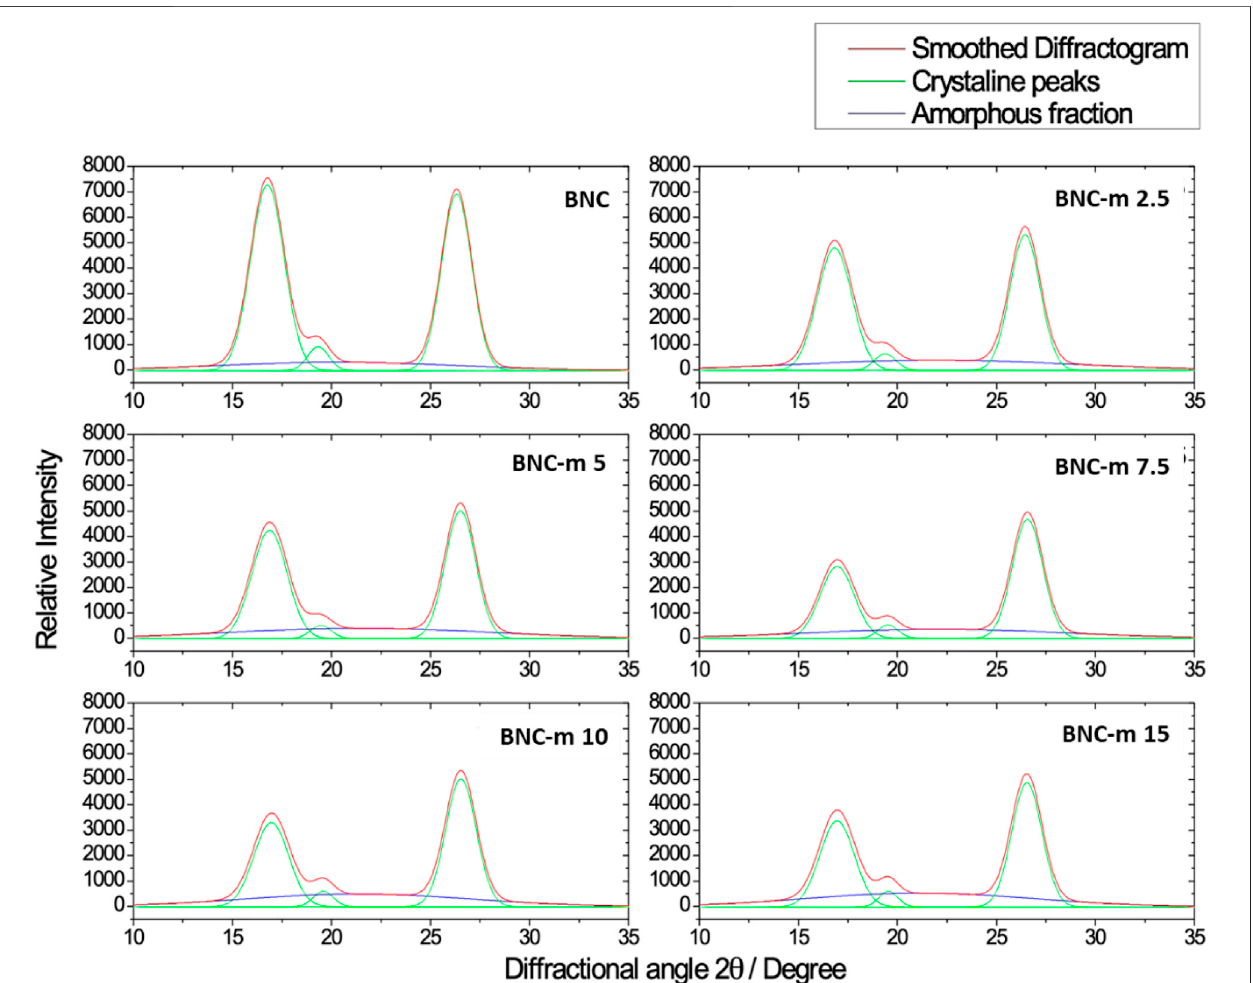
FIGURE 4 | Deconvolved diffractograms for BNC and